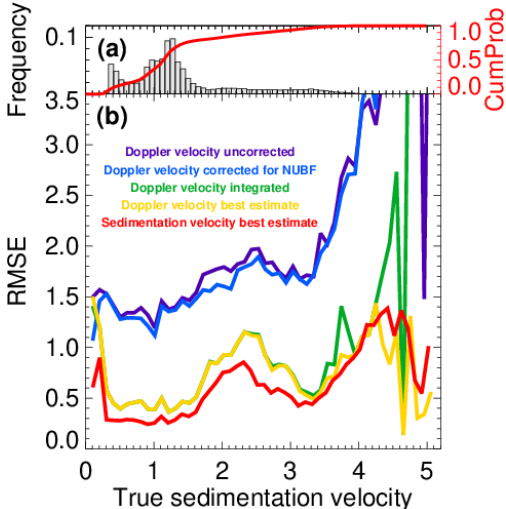
Figure 6. (a) The frequency of occurrence and the cumulative distri- bution of occurrence of Doppler velocities in the three ECCC scenes and (b) the root mean square error (RMSE) in Doppler velocity es- timation as a function of the magnitude of the true sedimentation velocity for the three GEM